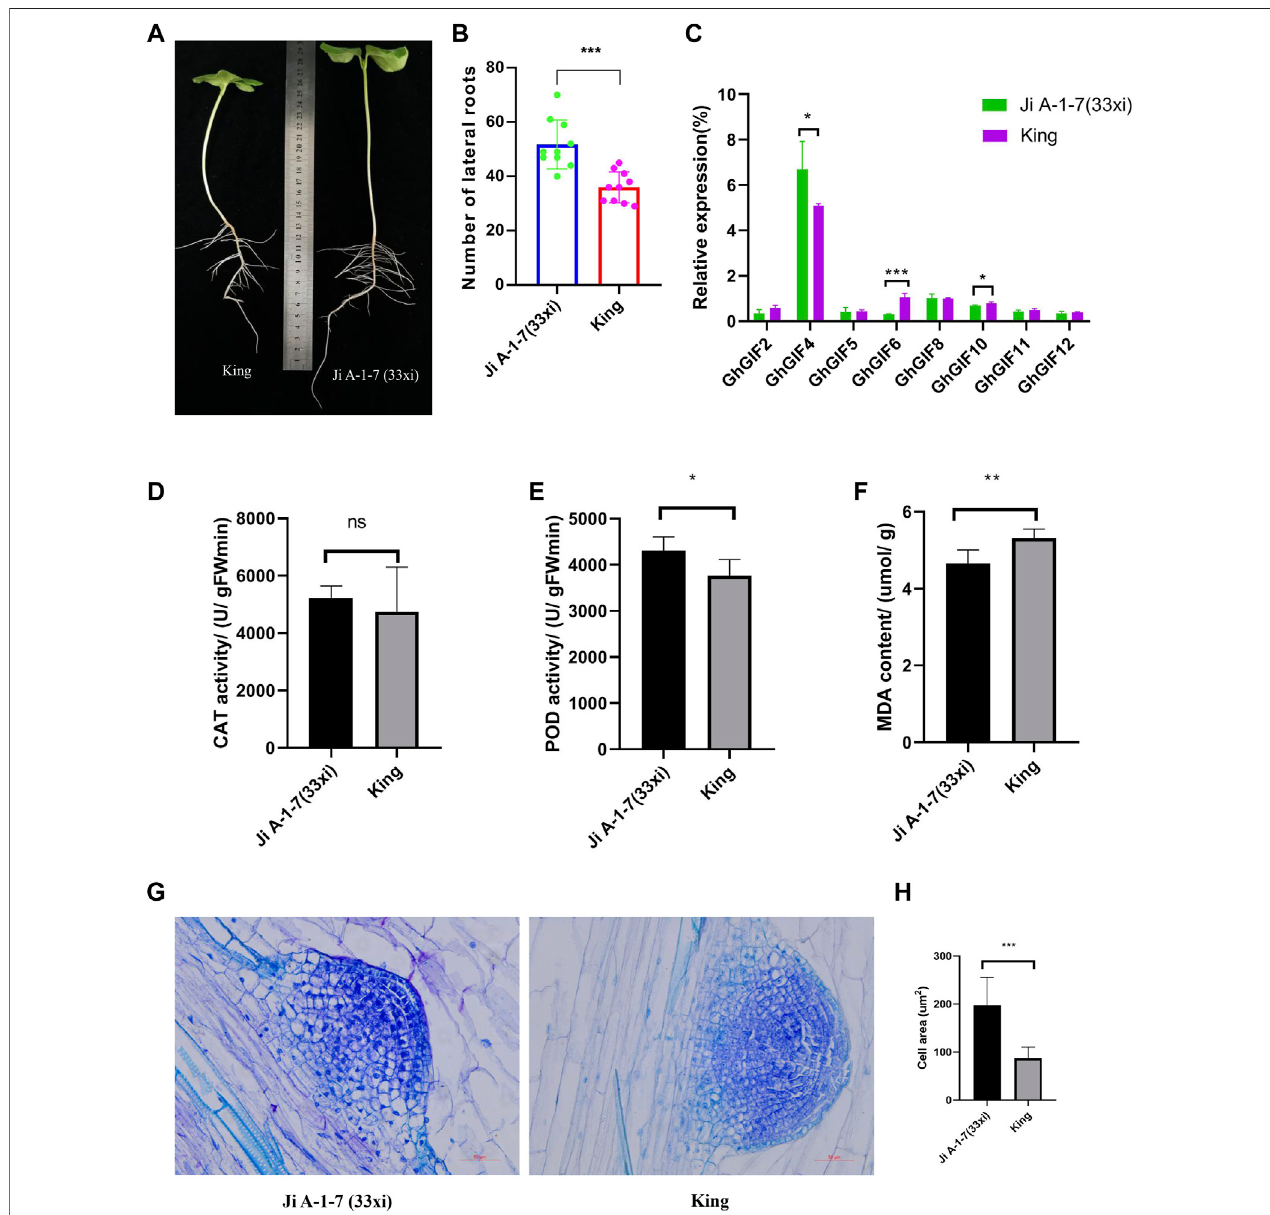
FIGURE 5 | Comparison of lateral roots between Ji A-1-7 (33xi) and King. (A) Phenotype of Ji A-1-7 (33xi) and King on the 8-days after sowing (B) Comparison of lateralrootnumbers (C) Relativeexpression ofeight GhGIF genesinlateralroots (D) CATactivity oflateralroots (E) PODactivity oflateralroots (F) MDAcontentoflateral roots (G) microstructure of the lateral root emergence part in Ji A-1-7 (33xi) and King (H) Comparison of cell area between Ji A-1-7 (33xi) and King.